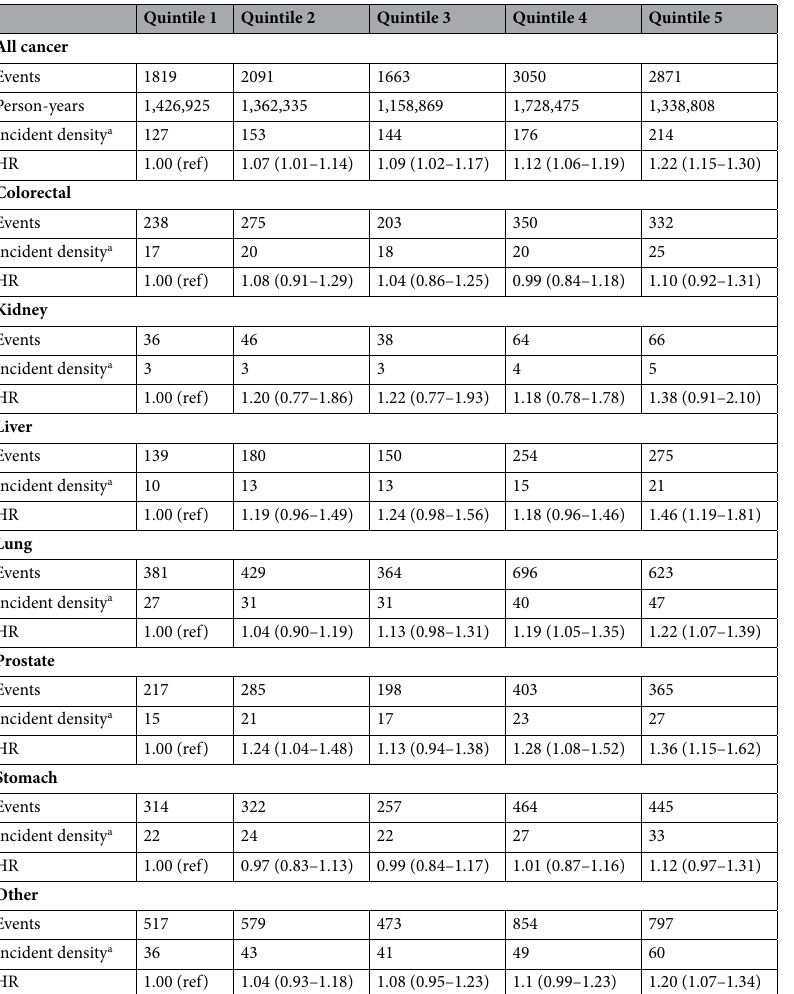
Table 2. Hazard ratios for all cancer and site-specific cancers according to the quintile groups of body weight variability. Model was adjusted for age, hypertension, diabetes mellitus, dyslipidemia, moderate physical activity, alcohol consumption, current smoker, mean weight and weight change. a Incident density is calculated as cases divided by 100,000